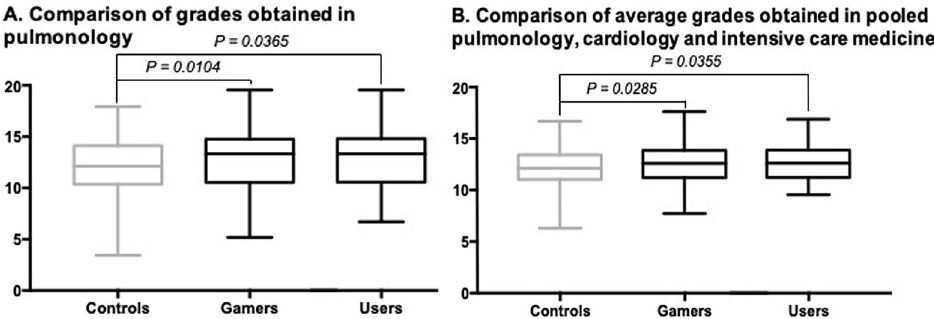
Fig 3. A. Comparison of grades obtained in pulmonology. B. Comparison of average grades obtained in pooled pulmonology, cardiology and intensive care medicine (PCC).